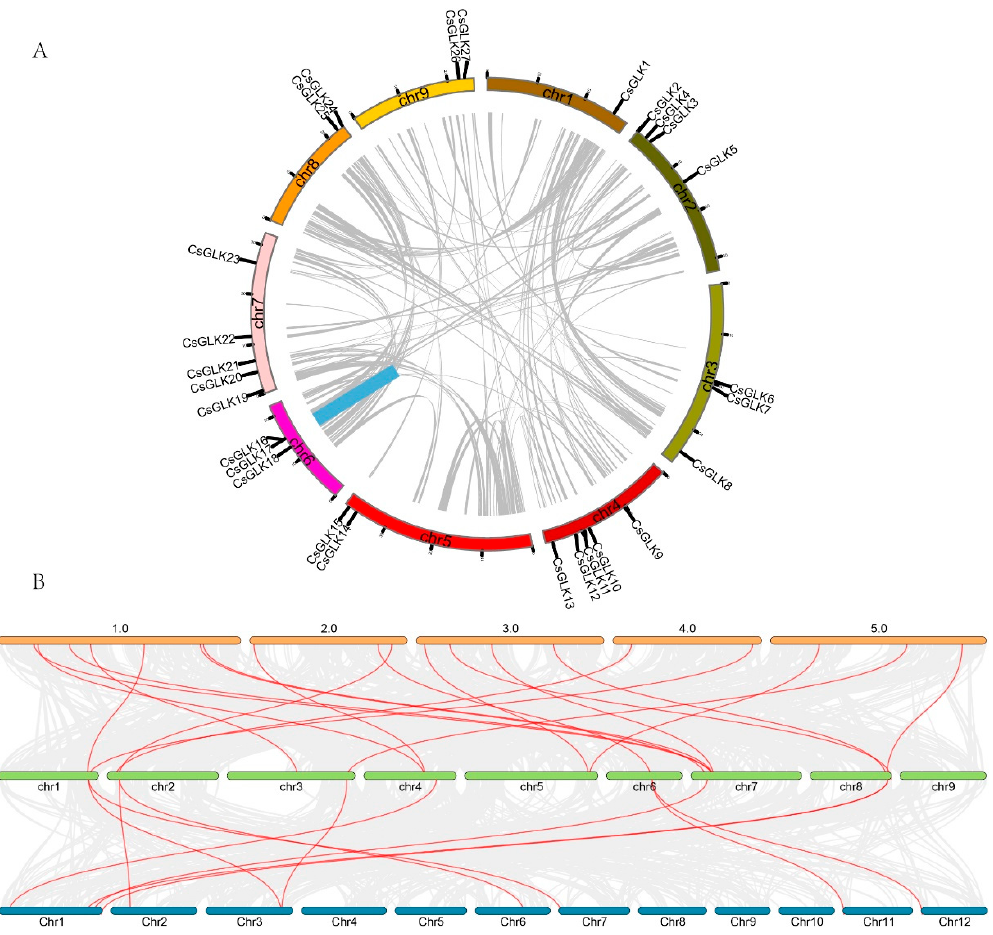
Figure 5. Collinearity analysis of CsGLK . ( A ) GLK gene replication event. The grey line represented all autosomes in the Citrus genome, and the blue line represented CsGLK gene replication events. ( B ) The homologous gene pairs between sweet orange and Arabidopsis and sweet orange and rice. The yellow chromosome represented Arabidopsis , the blue chromosome represented rice and the green chromosome represented Citrus . Red lines indicated homologous gene pairs.